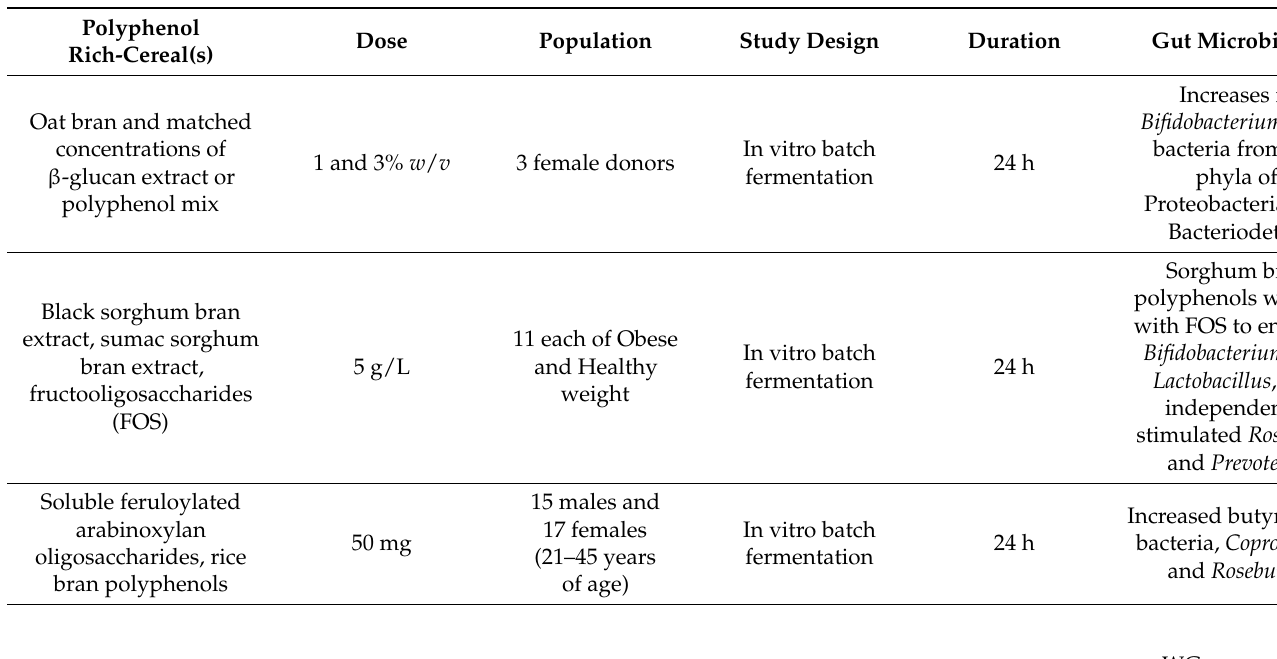
Table 4. Impact of cereal grain polyphenols on gut microbiome composition and